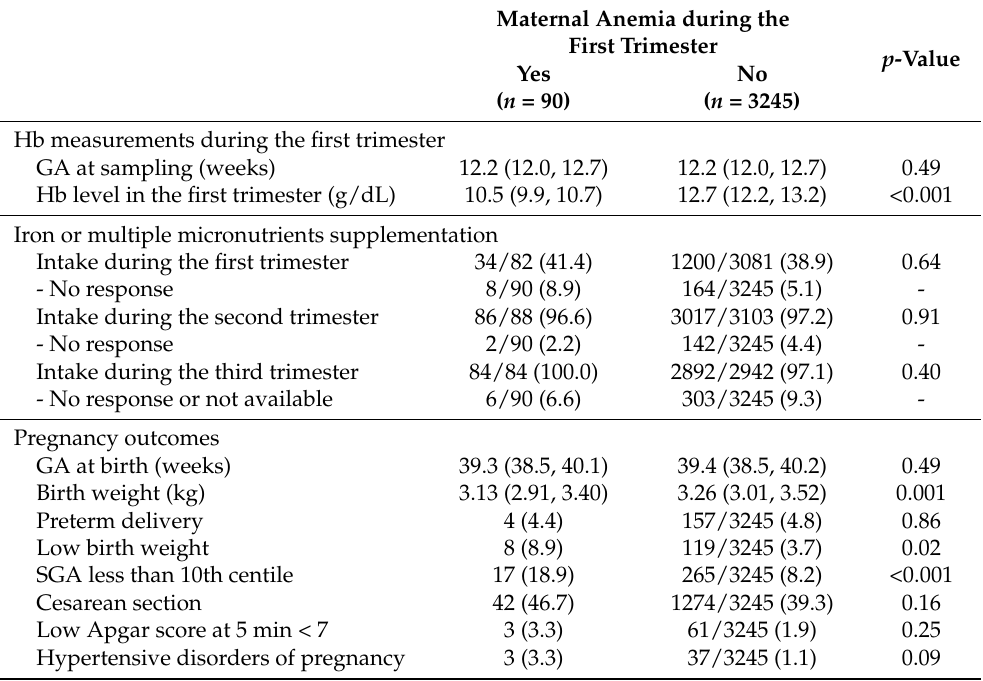
Table 3. Comparison of pregnancy outcomes between women with and without anemia during the first trimester.